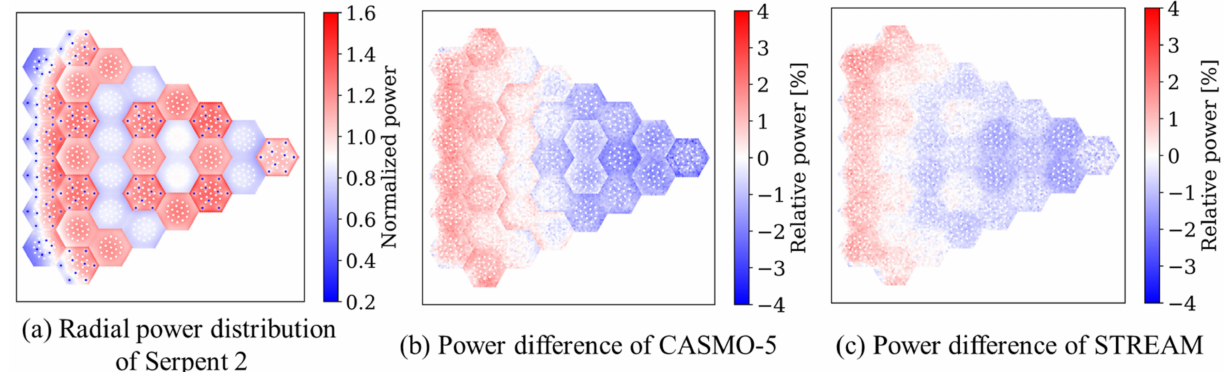
Figure 17. Radial power distribution of Serpent 2, STREAM and